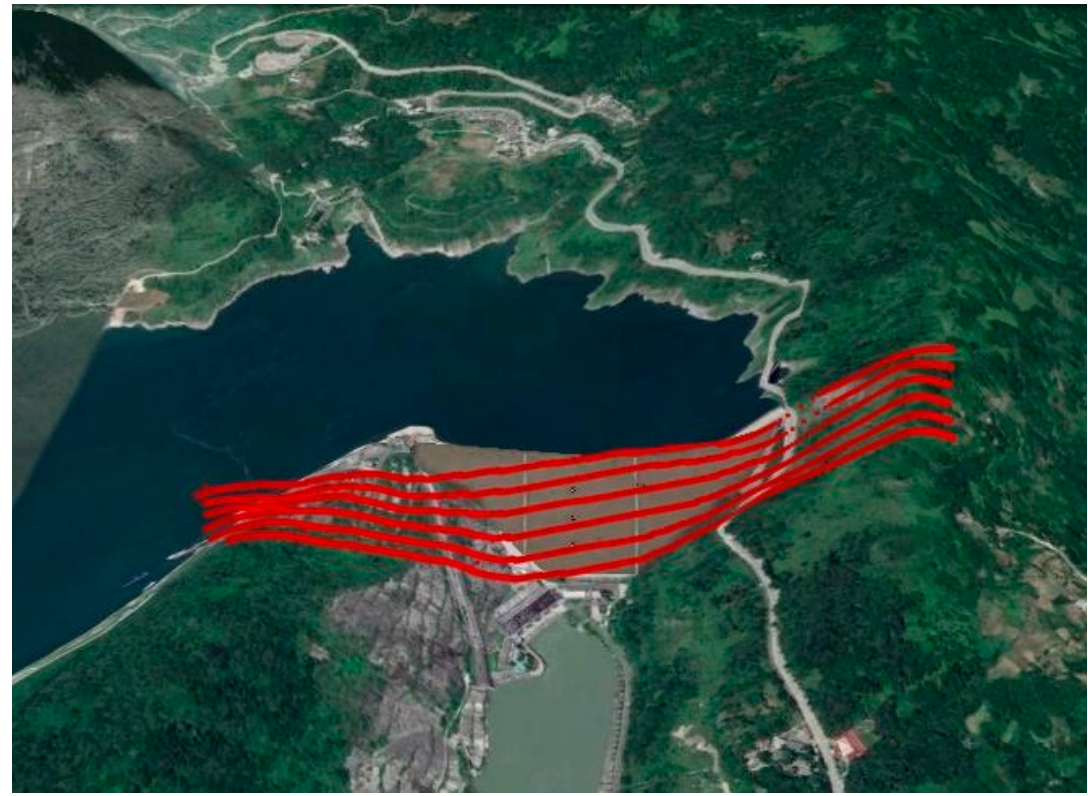
Figure 13. The TomoSAR results displayed in Google Earth, where the TomoSAR results of six azimuth lines in the test area were input into Google Earth for viewing.